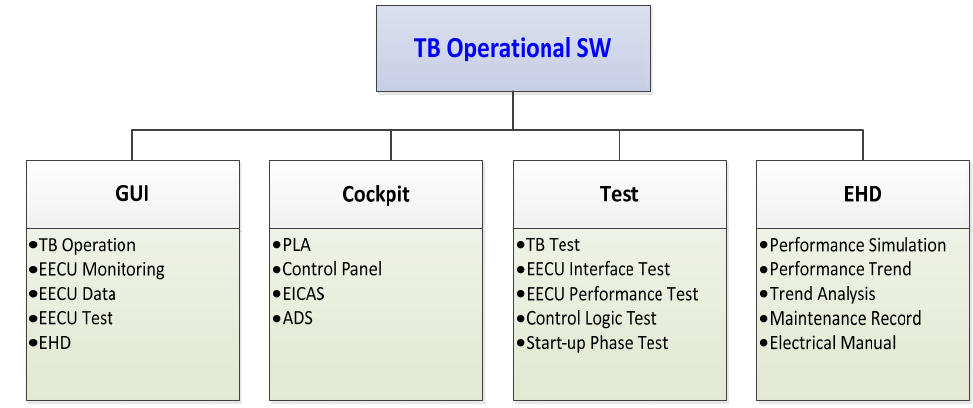
Figure 4. Structure of test bench hardware.